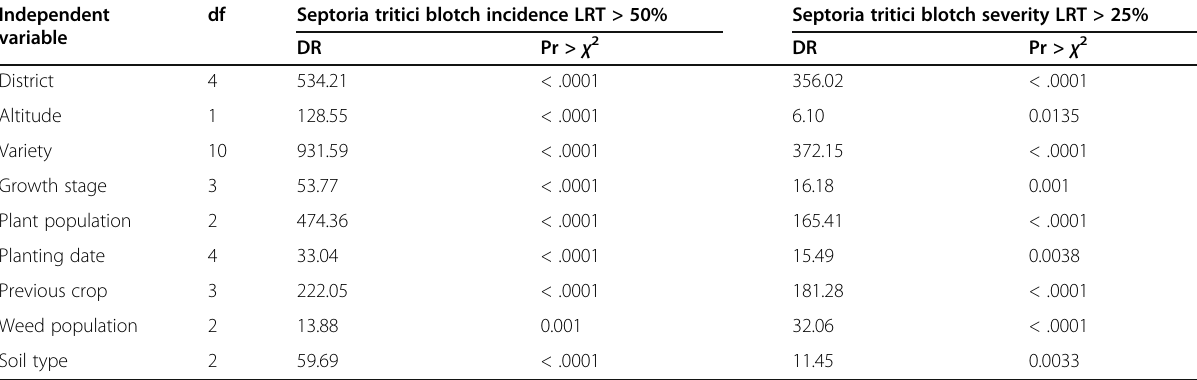
Table 3 Independent variables used in logistic regression modeling durum wheat incidence and severity and likelihood ratio test (LRT) for nine variables as single predictors of disease outcome Independent variable